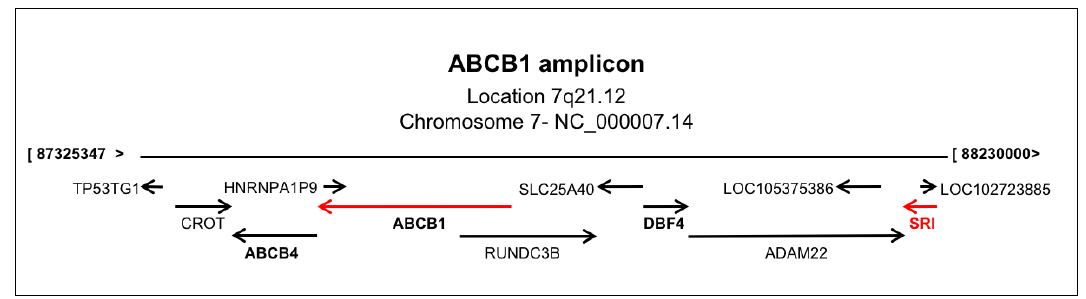
Figure 5. The ABCB1 amplicon, located in chromosomal region 7q21, containing the sorcin(SOluble Resistance-related Calcium-binding proteIN) ( SRI ) gene.